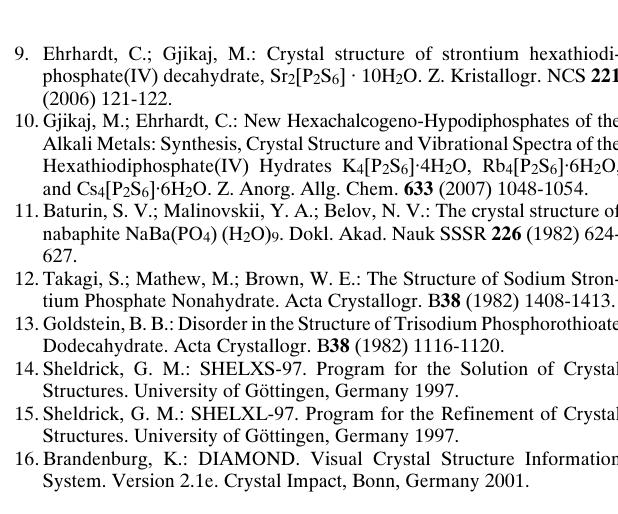
Alkali Metals: Synthesis, Crystal Structure and Vibrational Spectra of the Hexathiodiphosphate(IV) Hydrates K 4 [P 2 S 6 ]·4H 2 O, Rb 4 [P 2 S 6 ]·6H 2 O, and Cs 4 [P 2 S 6 ]·6H 2 O. Z. Anorg. Allg. Chem. 633 (2007) 1048-1054. 11.Baturin, S. V.; Malinovskii, Y. A.; Belov, N. V.: The crystal structure of